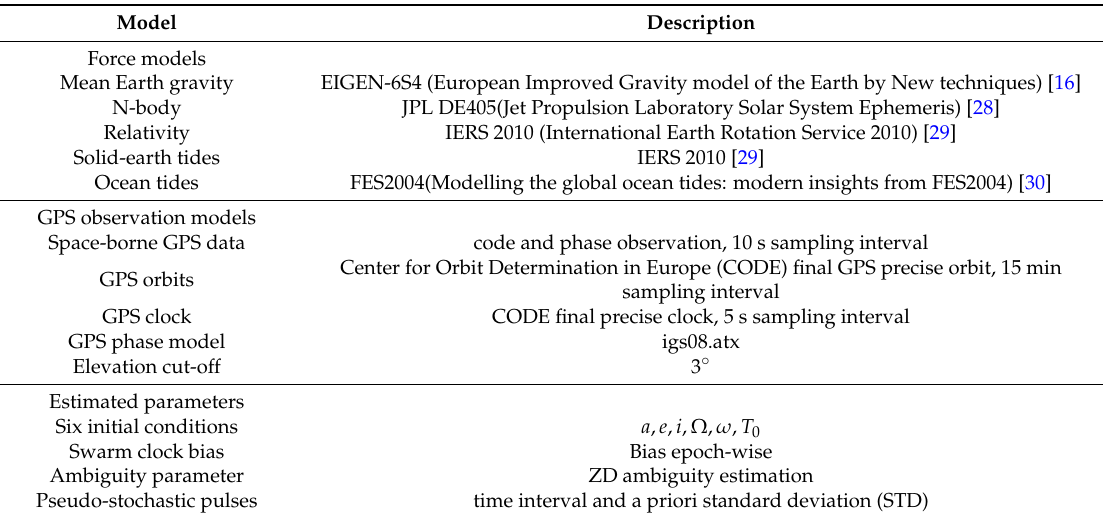
Table 1. The model standards adopted for Swarm zero-differenced (ZD) reduced-dynamic precise orbit determination